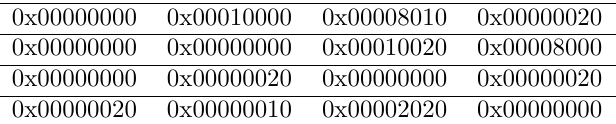
Table 8: Input difference in Phase 2.